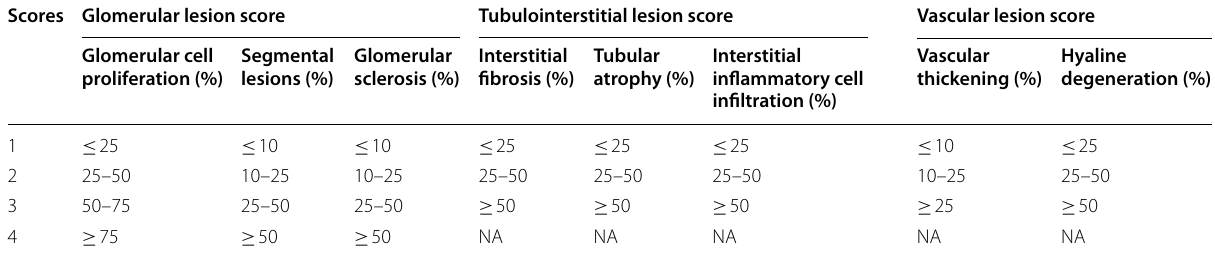
NA, not applicable